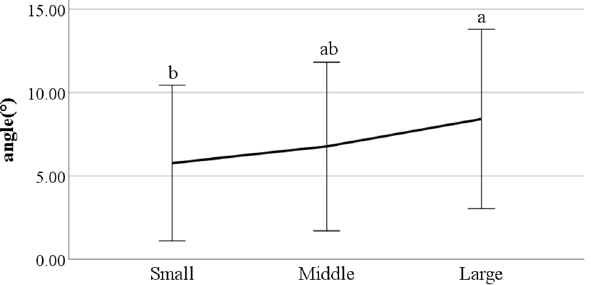
Figure 29. Flexion of the spinal column in the sagittal plane at toe-off (F value: 4.14, DF: 2, p -value: 0.02). Figure 30. Mean flexion of the spinal column in the sagittal plane (F value: 4.29, DF: 2, p -value: 0.02).